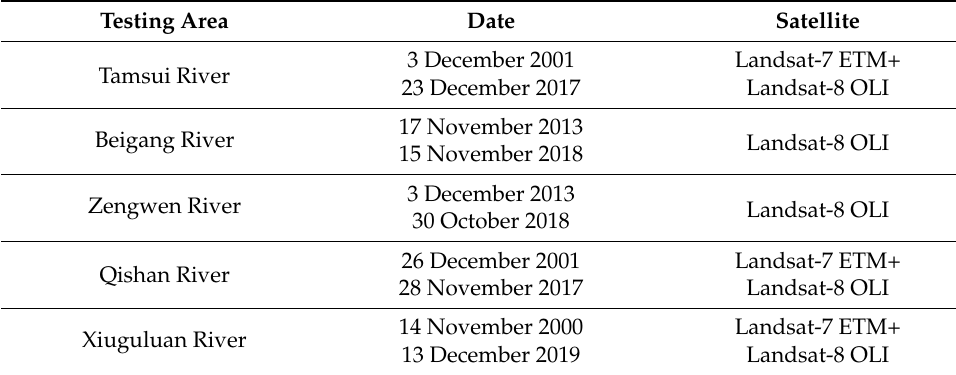
Figure 1. Locations of testing rivers. Table 1. Data of testing